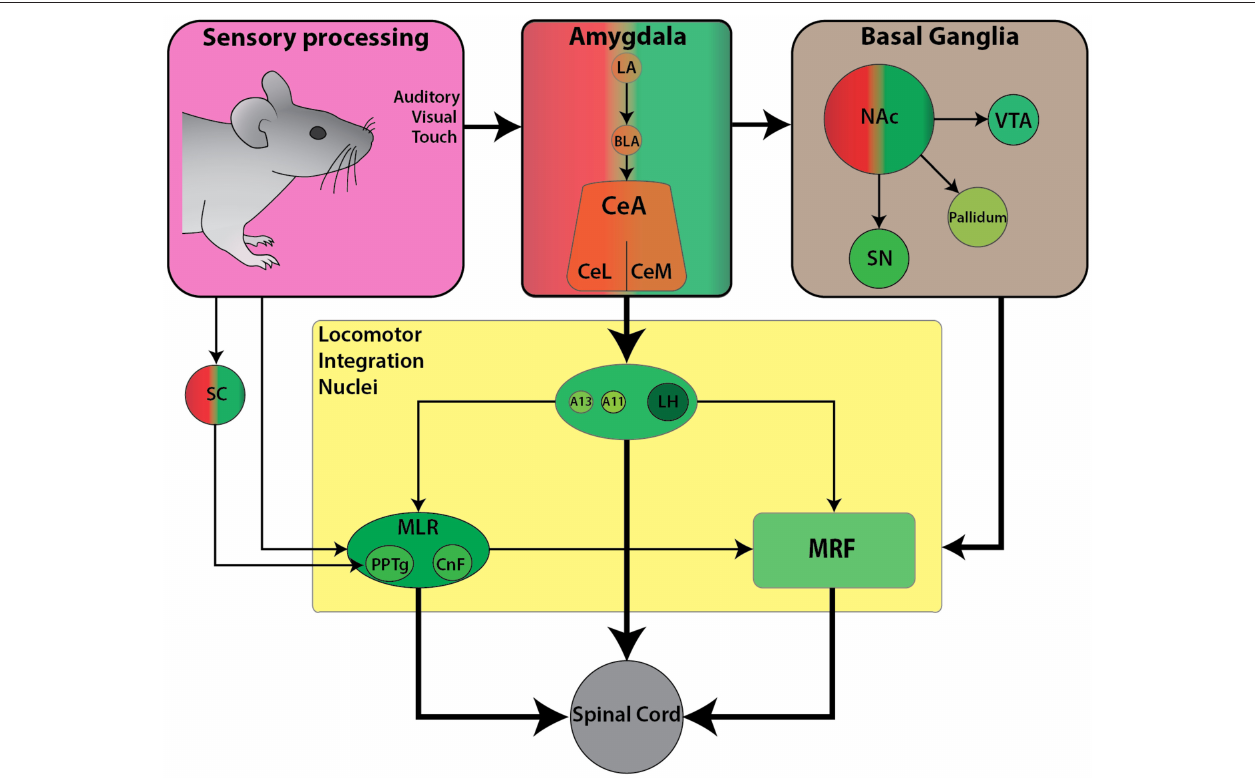
FIGURE 3 | Schematic diagram of the currently known descending connectivity of appetitive (approach) locomotor control. (Complementary to Figure 2D . Some connections omitted for lack of data or complexity of connectivity). Weighted arrows represent complex connectivity between regions described in further detail in text. Ascending connectivity has been omitted for